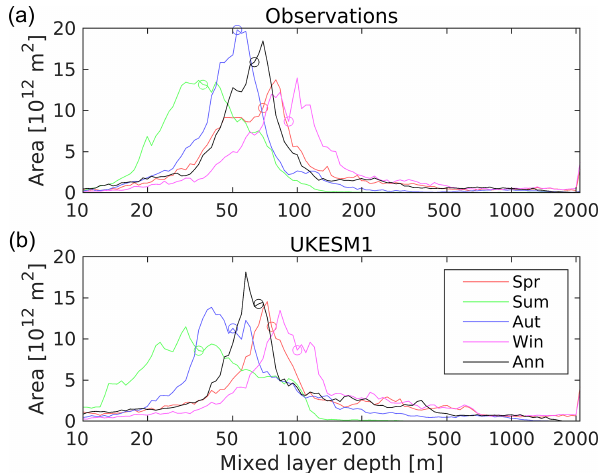
Figure 5. Frequency (in areal terms) of observation-derived ( a ; WOA) and simulated (b) seasonal mixed-layer depths. Mixed-layer depth derived here using a 5m temperature criterion (0.5 ◦ C) and full three-dimensional fields of potential temperature (Monterey and Levitus, 1997). Hemispheres have been temporally aligned so that seasons co-occur (i.e. summer is JJA for the north and DJF for the south). Circles indicate the medians for each seasonal period (i.e. the 50% of ocean area mark). Table 1. Selected ocean physical properties averaged across both the historical ensemble (upper rows) and corresponding segments of the piControl (lower italicized rows). For each property, the statis- tics refer to the full 165-year period from 1850–2015. The final statistic, M , is the linear slope of the change in the property across this full